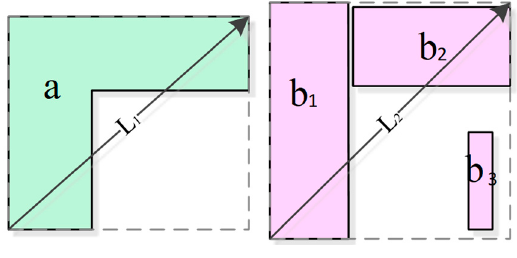
Figure 3. Directions of 𝒂 and 𝒃 .